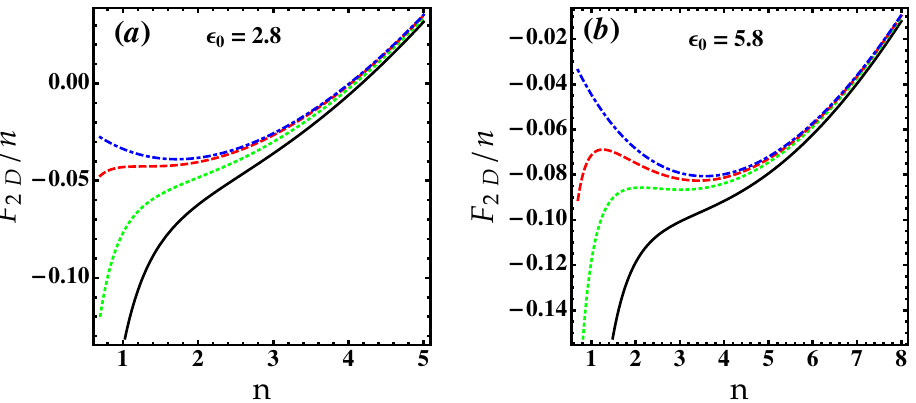
Figure 5. (Color online) ( a ) Two-dimensional free energy as a function of the density for different values of temperature, T / T BKT and for (cid:101) 0 = 2.8. Black lines: T / T BKT = 0.4. Green dotted lines: T / T BKT = 0.3. Red dashed lines: T / T BKT = 0.18. Blue-dot-dashed lines: T / T BKT = 0. ( b ) The same as ( a ) but for (cid:101) 0 = 5.8. Black lines: T / T BKT = 0.5. Green dotted lines: T / T BKT = 0.35. Red dashed lines: T / T BKT = 0.25. Blue-dot-dashed lines: T / T BKT = 0. Parameters are: g = 0.45, and g 12 =